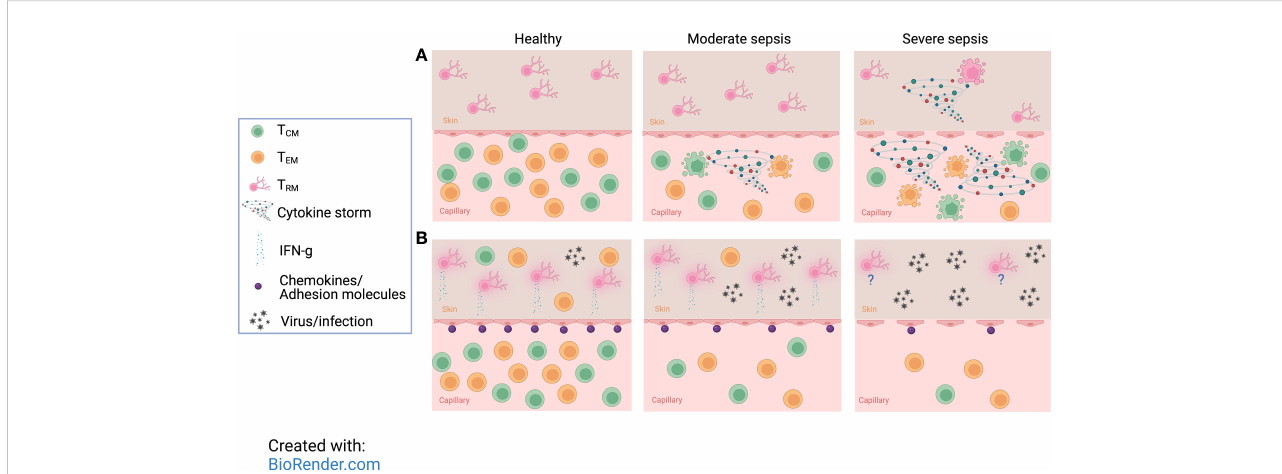
FIGURE 2 Severe sepsis imposes more drastic numerical and functional diminishment in memory CD8 T cells than moderate sepsis. (A) Despite rapid loss of CD8 T CIRCM , undamaged endothelial barriers protect tissue-resident memory CD8 T (T RM ) cells from moderate sepsis-induced apoptosis. However, severe sepsis not only causes a more drastic decline in number of T CIRCM , but it also overcomes the endothelial barrier and T RM become vulnerable to detrimental effects in fl icted by the sepsis-induced cytokine storm resulting in rapid apoptosis of T RM cells. (B) Moderate sepsis does not change the number and per cell function of T RM cells, but it reduces the ability of endothelial cells to upregulate chemokines and adhesion molecules in response to T RM -derived cues which leads to reduced recruitment of effector cells and poor protection against localized rechallenges. With increasing severity of sepsis, the protection against localized reinfections is even more compromised due to reduced number of T CIRCM and T RM . This fi gure was designed using “ The In fl ammatory response ” template available at BioRender.com.